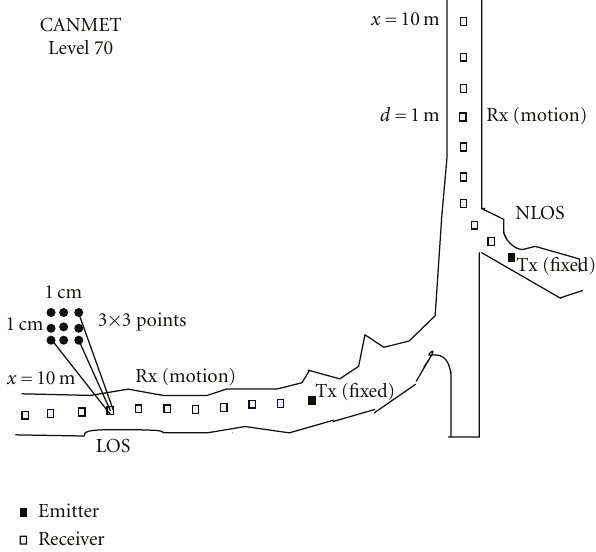
Figure 1: Map of the underground gallery at level 70.